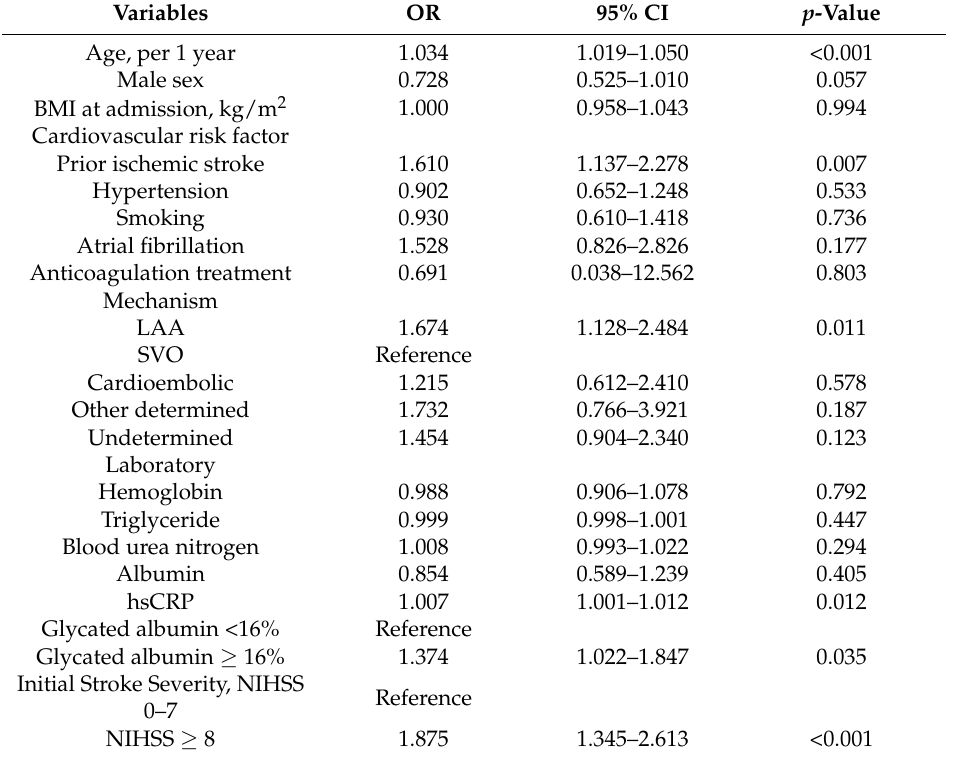
Table 3. Effect of GA on unfavorable short-term outcomes (compared to favorable 3-month mRS